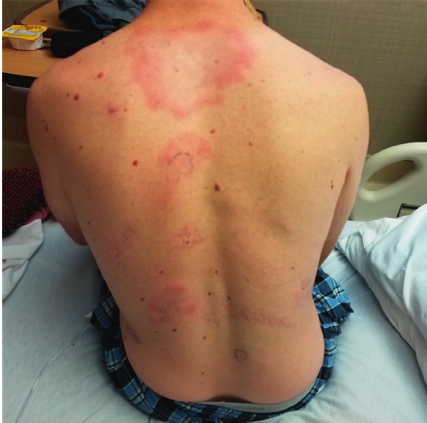
Figure 1: Photograph demonstrating the patient’s diffuse rash with multiple targetoid, erythematous, tender macules scattered across his trunk and